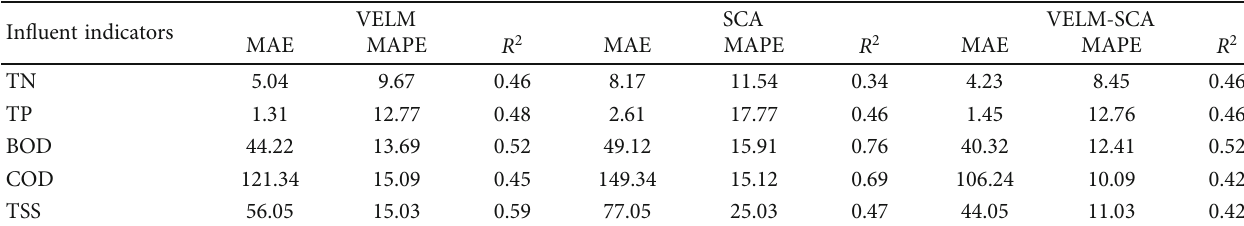
Table 6: Parametric values of MAE, MAPE, and R 2 using hybrid of VELM-SCA. In fl uent indicators